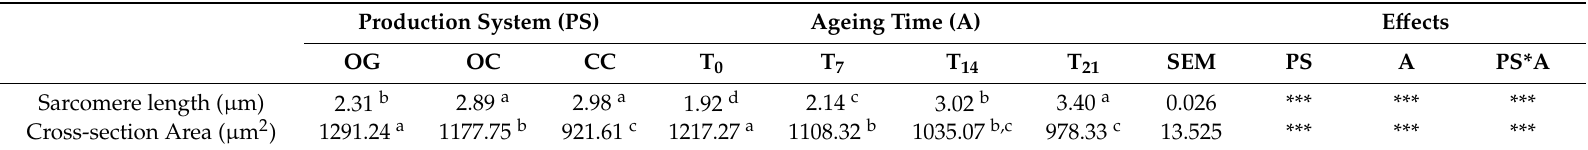
Table 3. E ff ect of the production systems (organic grazing, OG; organic concentrate, OC and conventional concentrate, CC) and ageing time (T 0 , T 7 , T 14 , T 21 : 0, 7, 14, and 21 days, respectively) on histological parameters of Longissimus thoracis from calves of the Retinta